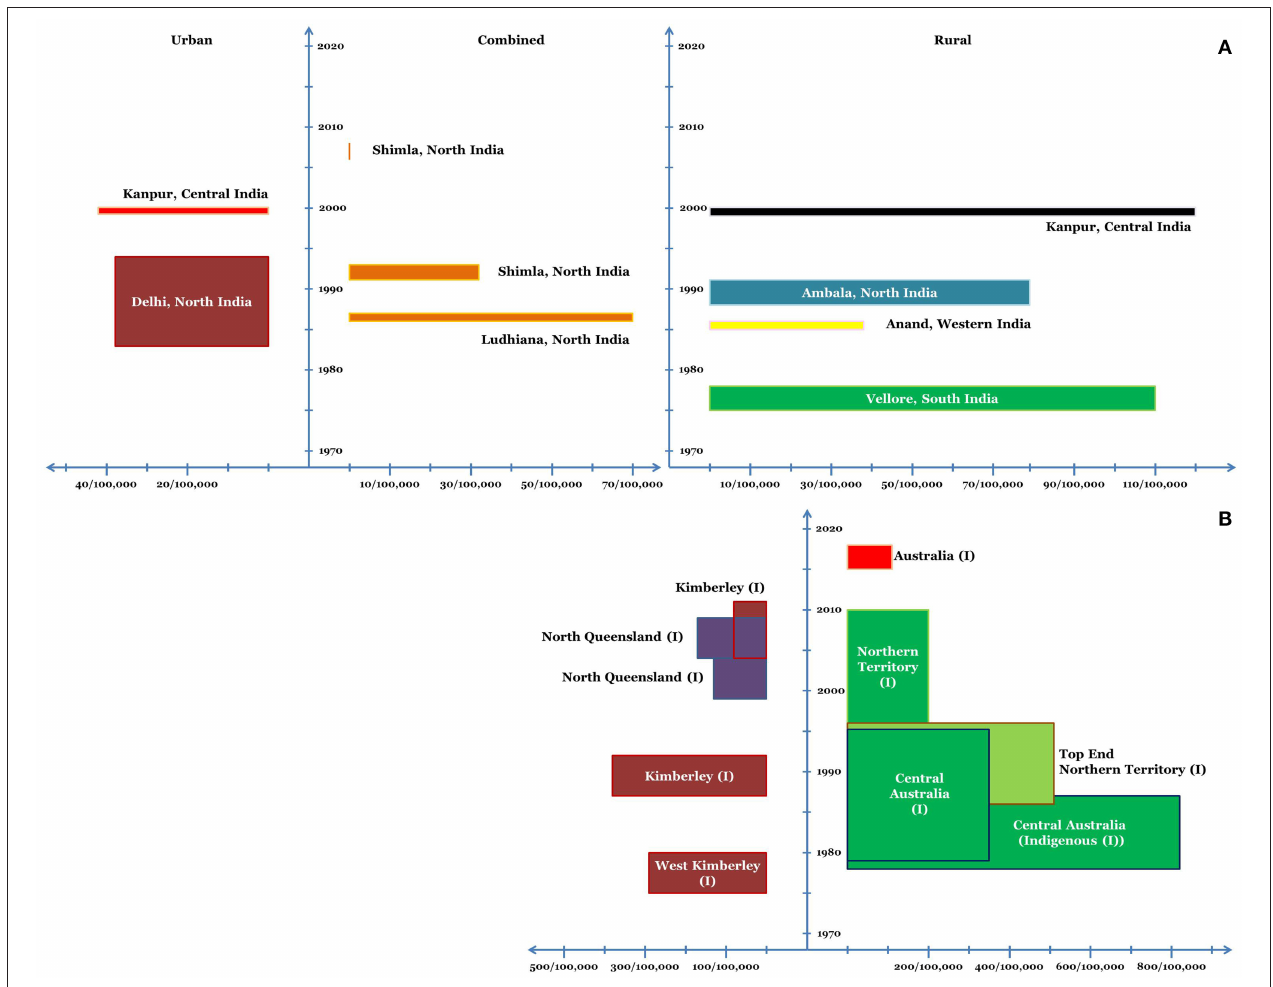
FIGURE 1 | Incidence of ARF in various regions of India (A) and Australia (B) in school-age children. (I) refers to the indigenous population. The x-axis depicts the incidence and the y-axis depicts the timeline. The dimension of the bars along the x-axis (length of the bars) depicts the average annual incidence of ARF. The dimension of the bars along the y-axis (width of the bars) corresponds to the duration for which the said average annual incidence was noted.